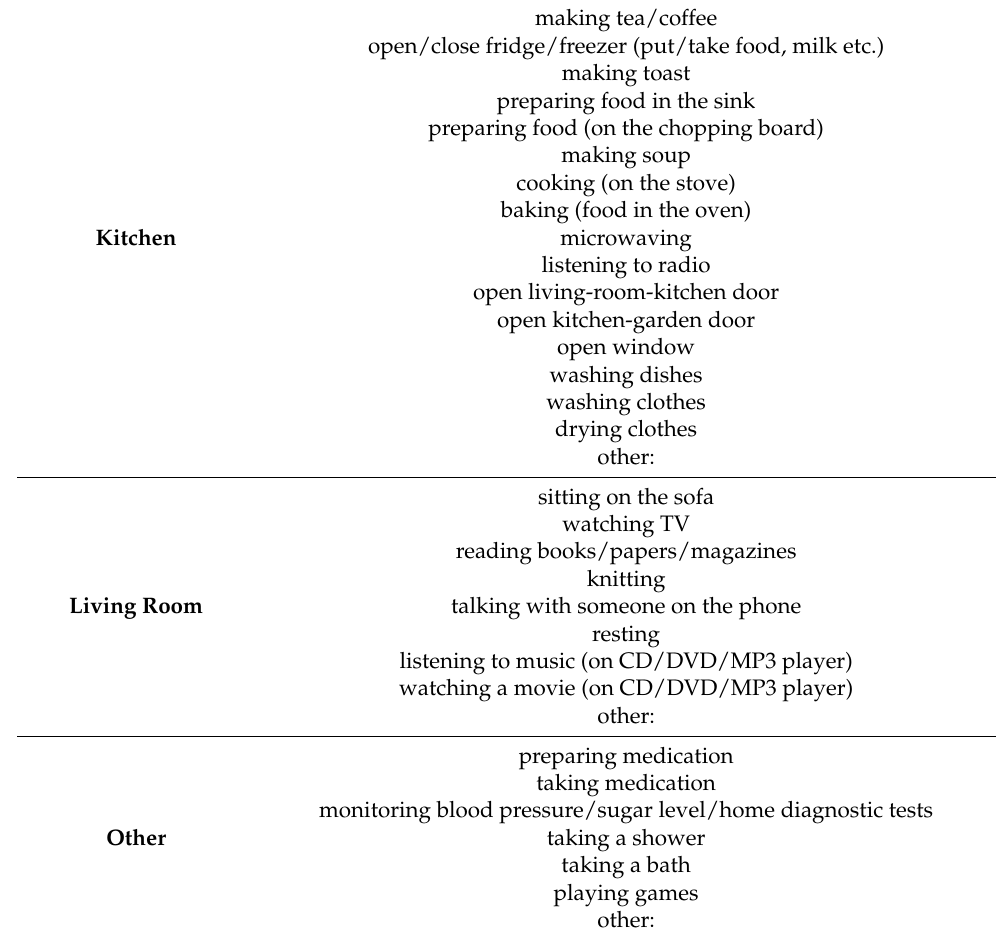
Table 2. Household activities